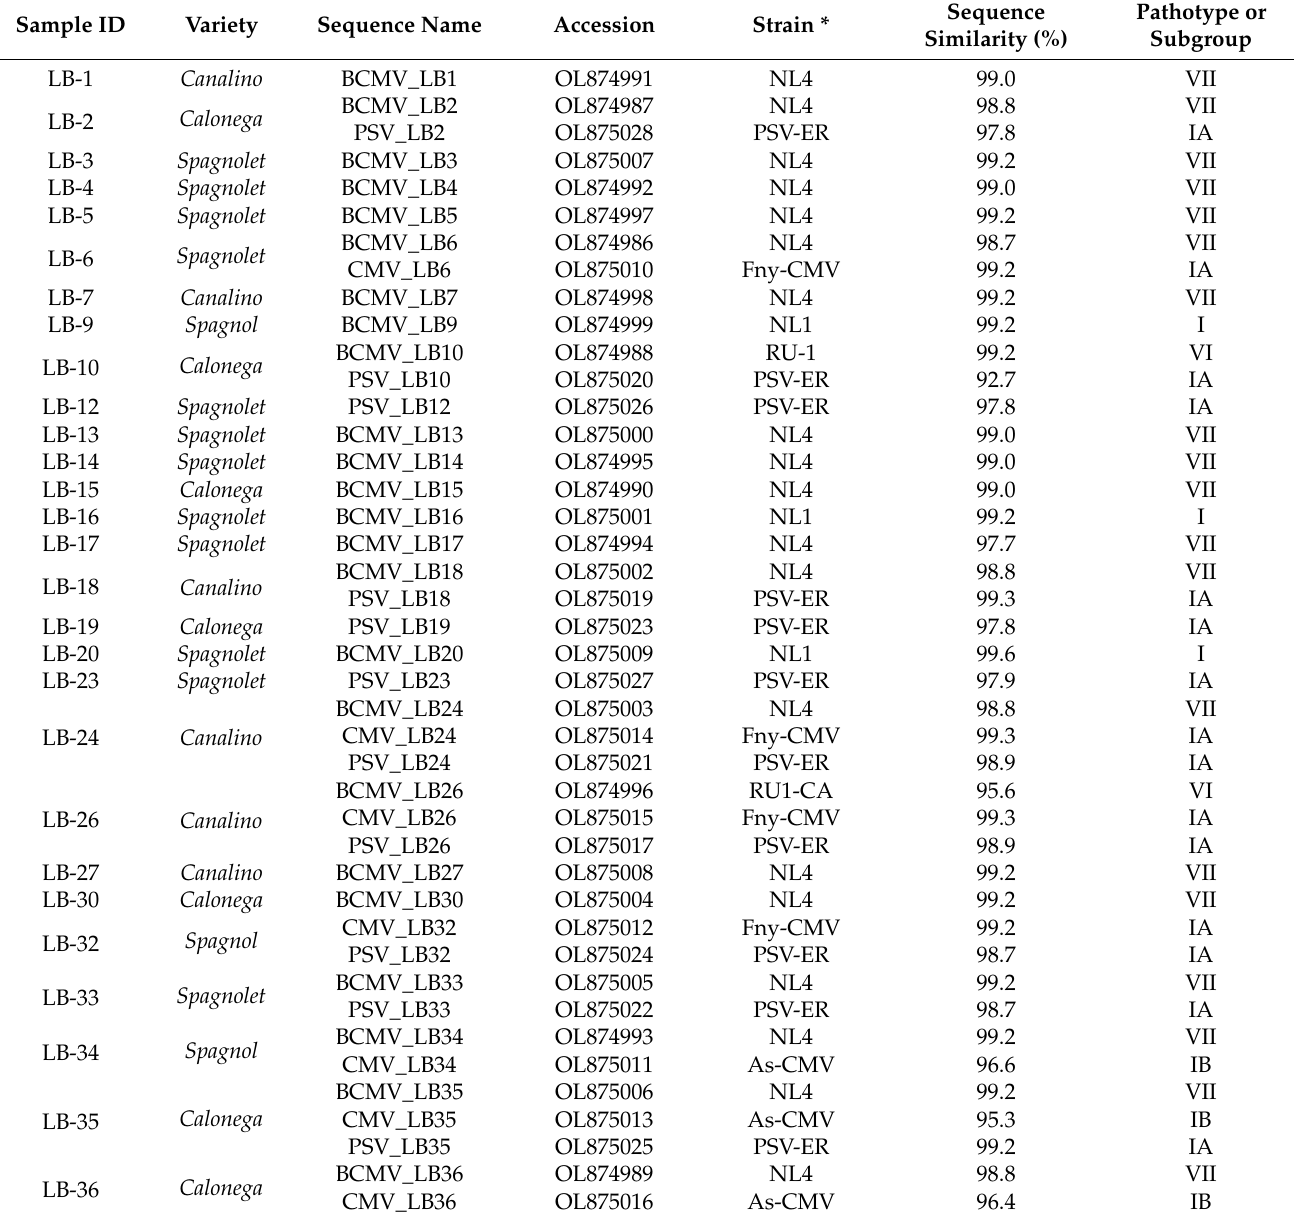
Table 3. BLAST analysis of viral sequences obtained by RT-PCR from Lamon bean